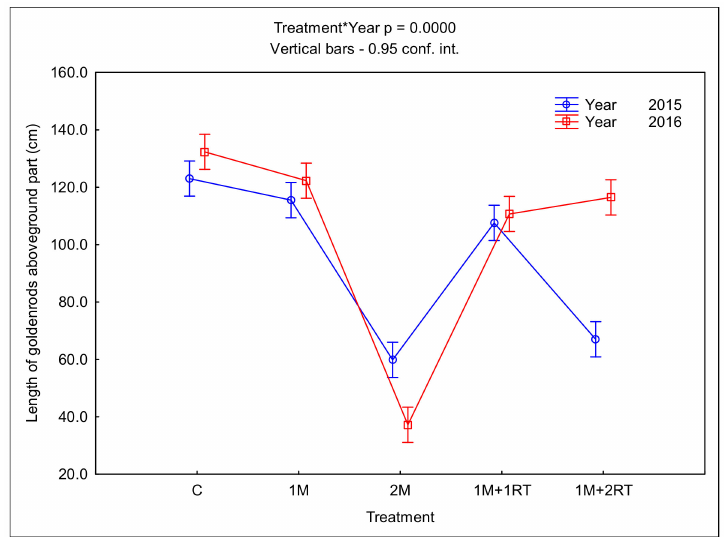
Figure 9. Mean length of the aboveground parts of goldenrods, depending on the type of mechanical treatment. The following symbols denote the research treatments: C: control; 1M: one-time mowing; 2M: two-time mowing; 1M + 1RT: one-time mowing with one-time rotary tilling; 1M + 2RT: one-time mowing with two-times rotary